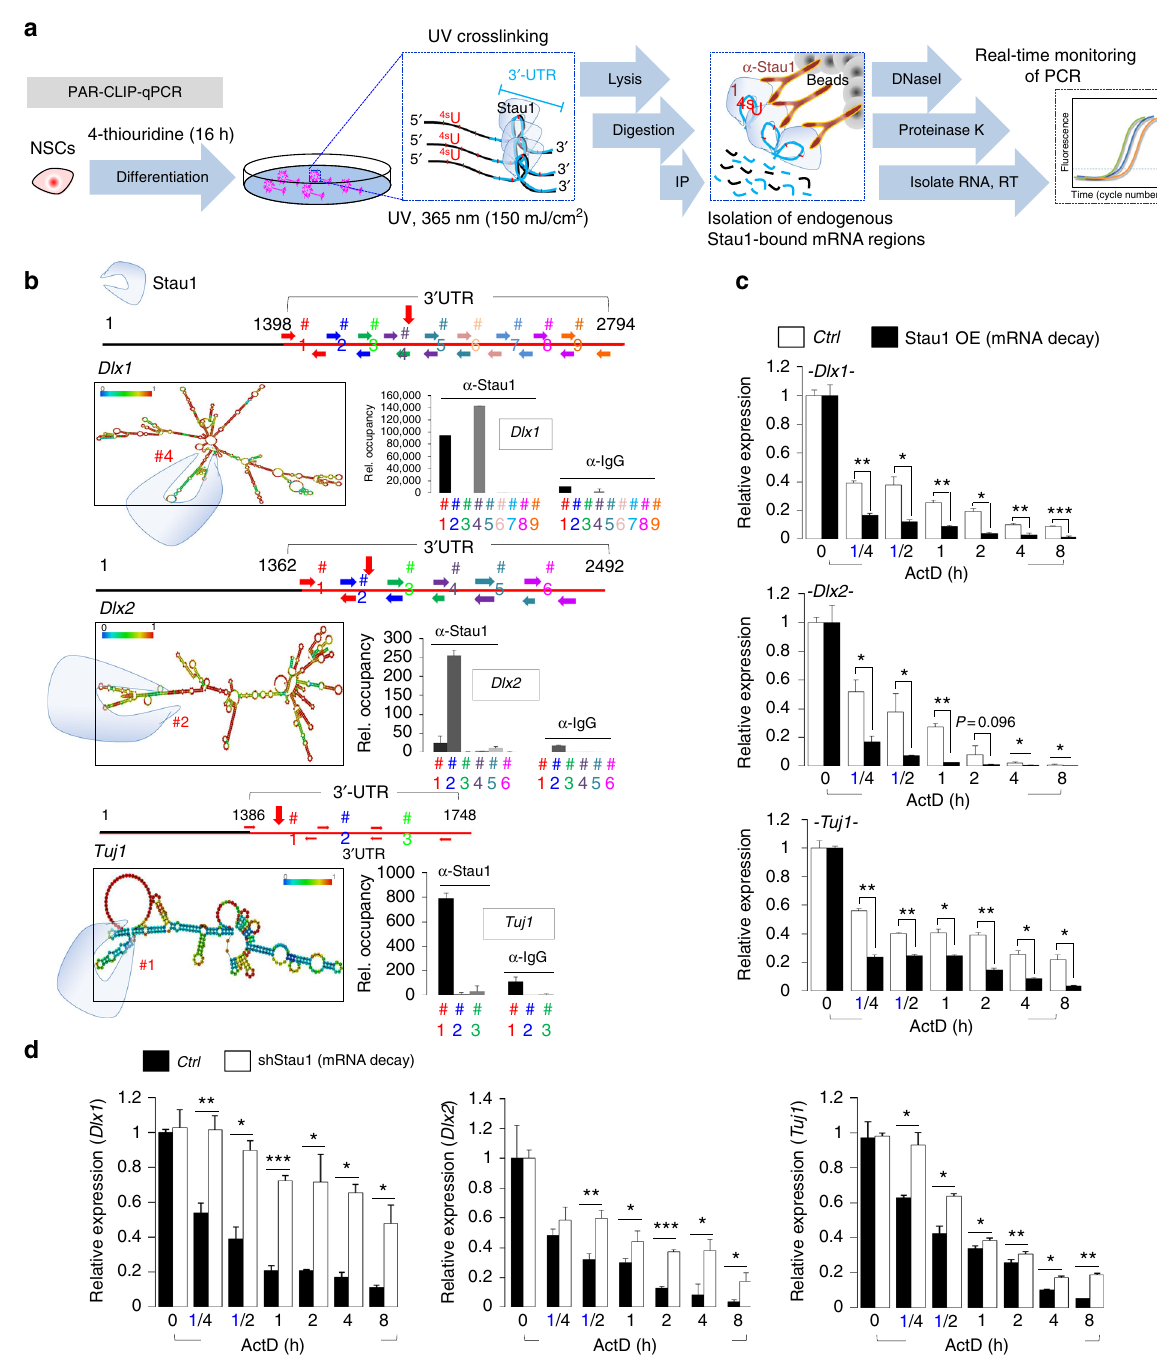
Fig. 5 Stau1 binds to neurogenesis-associated mRNAs and promotes their degradation. a Schematic showing use of PAR-CLIP-qPCR to detect Stau1 target mRNAs and binding sites. b (Left) RNA secondary structure prediction using online software (http://rna.tbi.univie.ac.at/) of hairpin formation in 3 ′ -UTR sequences of Dlx1 , Dlx2 , and Tuj1 . Potential Stau1 binding regions are marked with vertical red arrows. (Right) PAR-CLIP qPCR shows enrichment of Stau1 binding at various locations on indicated mRNAs. X -axis, primer sets; y -axis, relative fold change. c , d NPCs stably overexpressing (OE) Stau1 or control vectors ( c ) or infected with shScramble or shStau1 lentiviral vectors ( d ) were treated with actinomycin D (5 μ g/ml) for indicated times and mRNAs were prepared for RNA stability assays ( n = 3). Results were normalized to control NPCs at 0 h. Data are presented as mean ± SD. t tests were conducted to calculate statistical signi fi cance (* P < 0.05, ** P < 0.005, *** P < 0.0005). See also Supplementary Fig. 9a, d and 10a –